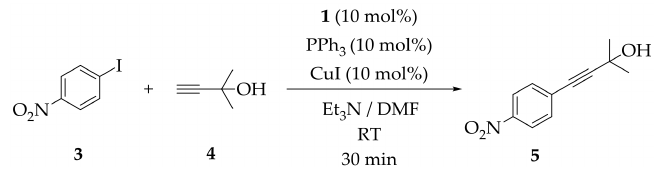
Scheme 3. Model reaction for catalytic